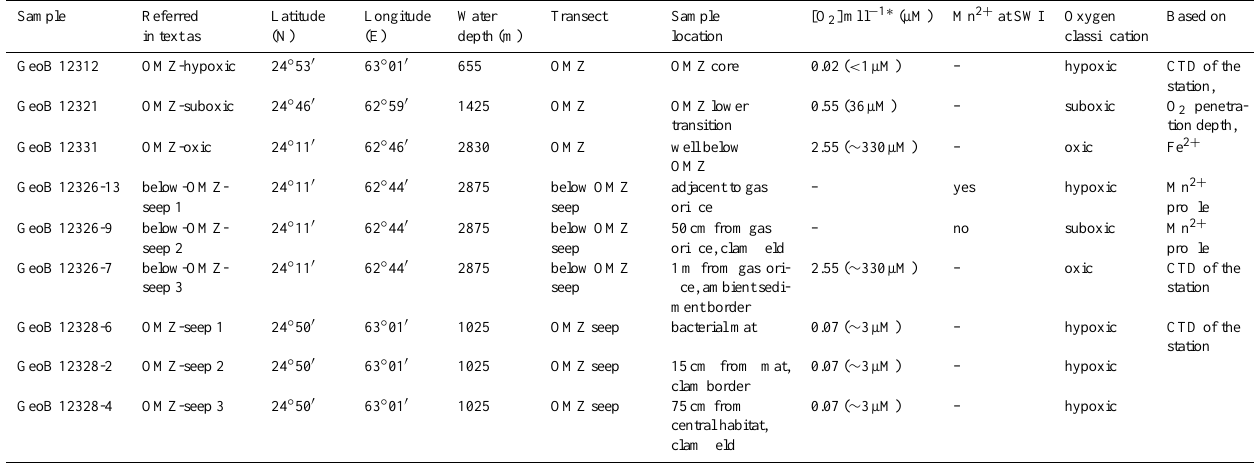
Table 1. Sample location descriptions and oxygen classification scheme